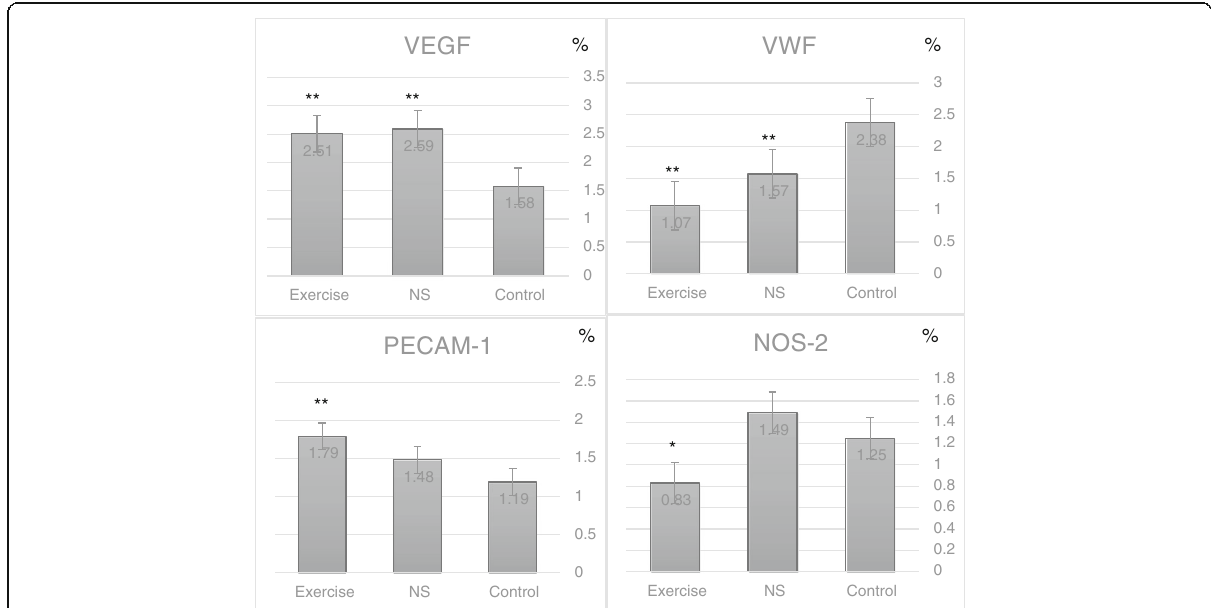
Fig. 2 Comparison of the angiogenic growth factors and antigens (VEGF, VWF, PECAM-1, and NOS-2) between the experimental groups: Control, NS ( Nigella sativa fed), Exercise (Exercise trained), * P < 0.05, ** P <